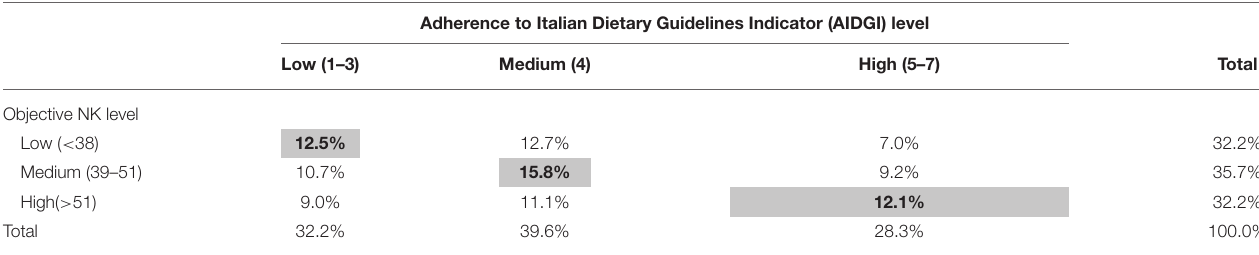
TABLE 6 | The NK-Adherence to Italian Dietary Guidelines Indicator (AIDGI) map. Adherence to Italian Dietary Guidelines Indicator (AIDGI)